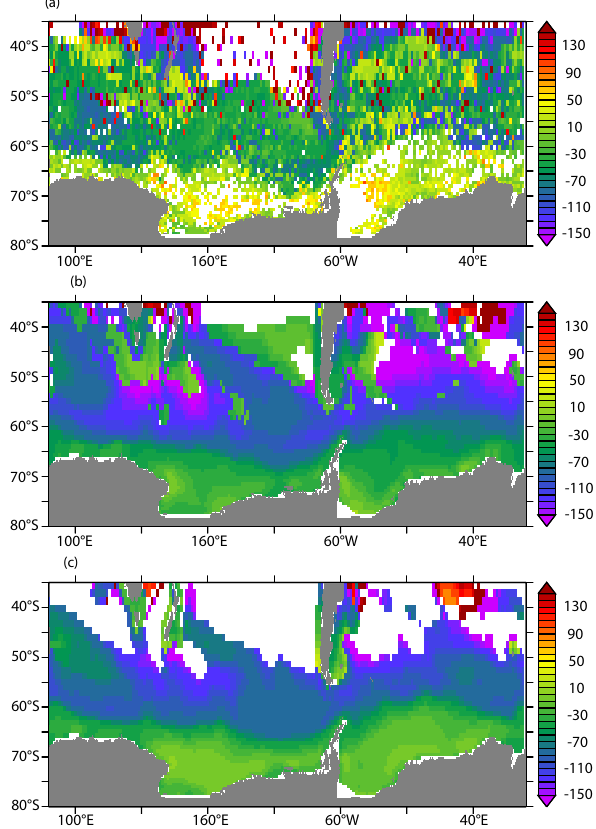
Figure 8. Phasing of the bloom onset timing for (a) SEAWIFS, (b) CNTRL, and (c) WSTIR; units are days for a climatological year. Regions where the quantity is not well or defined or where the quan- tity and/or bloom are not well-defined are shown in